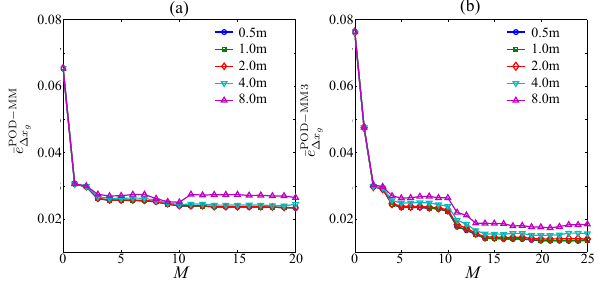
Figure 15. The errors (a) ¯ e POD - MM and (b) ¯ e POD - MM3 versus M 1x g 1x g for different 1x g at site A for site-independent ROM constructed using POD-MM and POD-MM3 methods, respectively. The means are taken over 1998, 1999, 2000, 2002, and 2006.